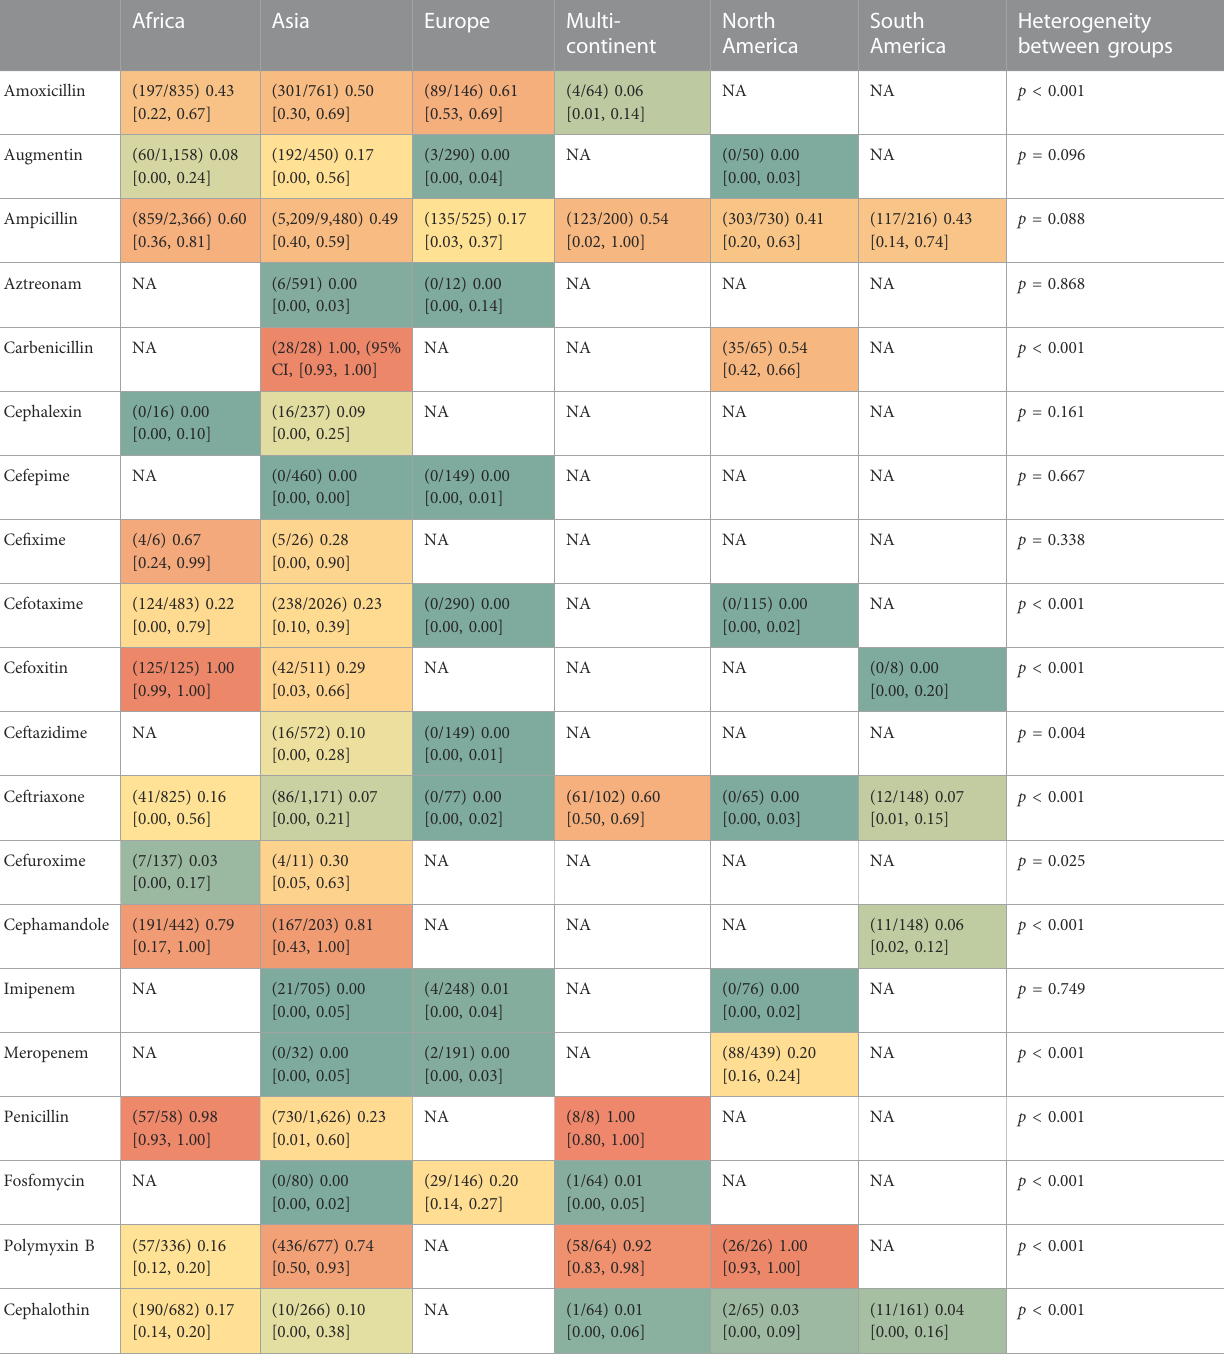
Legend: The heatmap of weighted proportions of